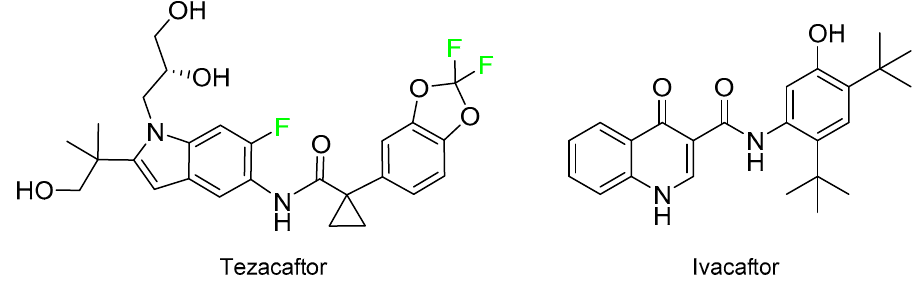
Figure 11. Structure of Symdeko ™ , a drug combination.